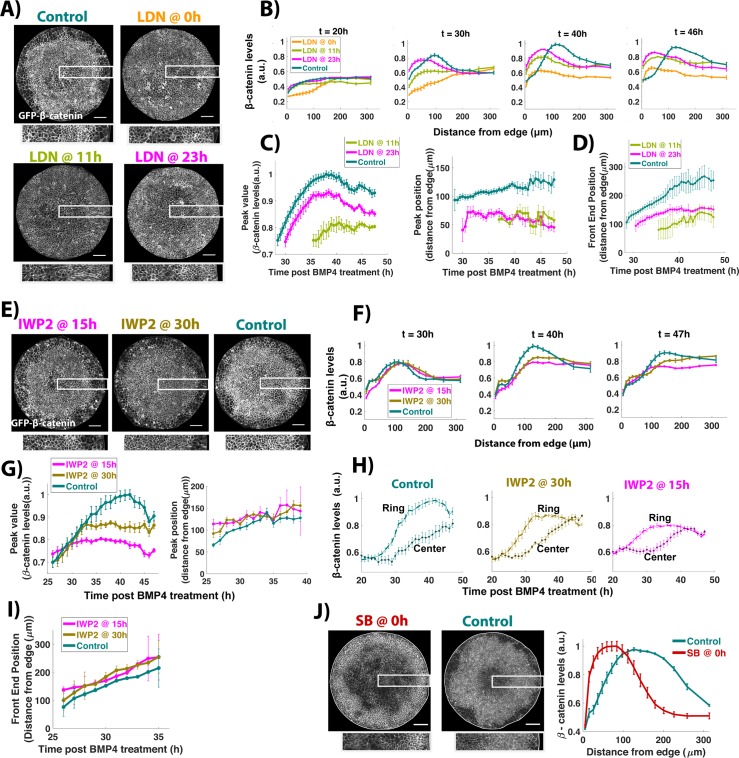
Regulation of WNT signaling activity by BMP, WNT, and NODAL.(A, E) Snapshots of GFP-β-catenin hESCs from time-lapse imaging movies at 46 h post BMP treatment. Time between BMP4 and LDN or IWP2 addition is indicated above each image. Boxes show the region represented at higher magnification below each colony image. (B, F) Average nonmembrane β-catenin levels as a function of radial position. Control represents samples with no inhibitor addition. The timing of LDN or IWP2 addition after BMP4 treatment for each curve is shown in the legend, while the time being analyzed in shown above the plot. Error bars represent standard error. N = 3 colonies for the samples LDN at 0 h (LDN@0h), LDN at 11 h (LDN@11h); for all other samples N ≥ 5. (C, G) Temporal evolution of the position and intensity of peak signaling (defined by maximal nonmembrane β-catenin intensity). (D, I) Temporal evolution of the front of the domain of active signaling. In (C, D, G, H, and I) at time points earlier than the first one in each curve, signaling was below threshold signaling at all positions. (H) Temporal evolution of average nonmembrane β-catenin levels in a narrow ring inside the region of mesodermal differentiation (distance from edge: 134–150 μm) and at the center (distance from edge: 277–350 μm) of the colony. (J) Images of GFP-β-catenin hESCs at 46 h post treatment with either BMP4 (control) or BMP4 and SB. Average nonmembrane β-catenin levels as a function of radial position at 46 h. Error bars represent standard error. N ≥ 6. Underlying data can be found in S5 Data. BMP, Bone Morphogenic Protein; GFP, Green Fluorescent Protein; hESC, human embryonic stem cell; LDN, LDN193189.